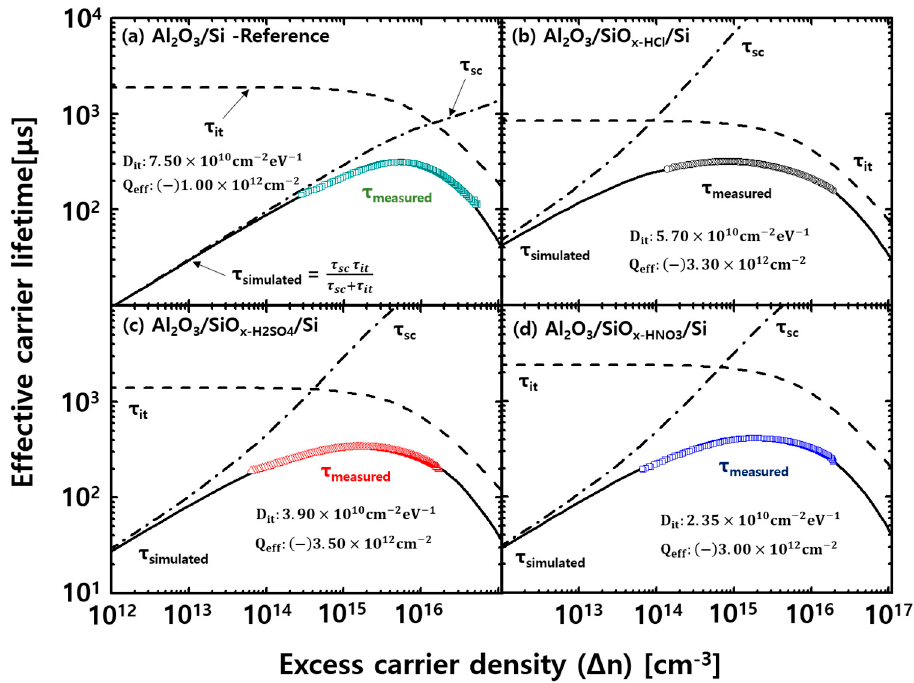
Figure 6. Measured and simulated effective carrier lifetime curves at Al 2 O 3 /SiO x-acidic /Si structures as a function of excess carrier density ( Δ n ). The solid line indicates the simulated effective carrier lifetime ( τ simulated ), the dash line indicates the effective carrier lifetime via interface state ( τ it ), and the dotted dash line indicates the effective carrier lifetime via surface space charge region ( τ sc ). The electron and hole capture cross-sections are assumed to be equal, σ n = σ p = 1 × 10 15 cm 2 .